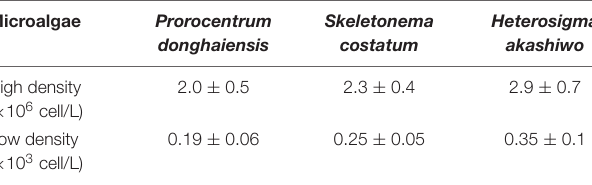
TABLE 1 | EC50 (g/L) of hijiki extract on three species of